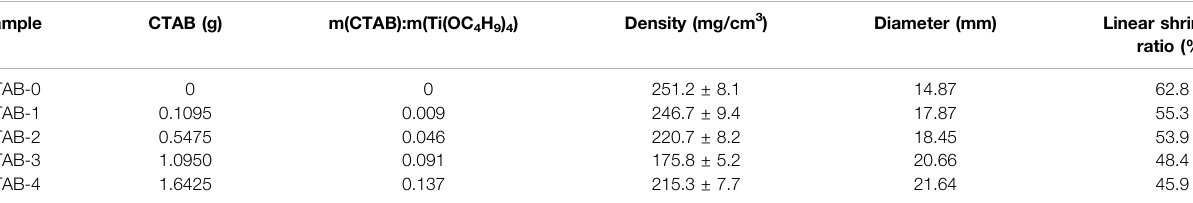
TABLE 1 | Parameters of different TiO 2 aerogels.